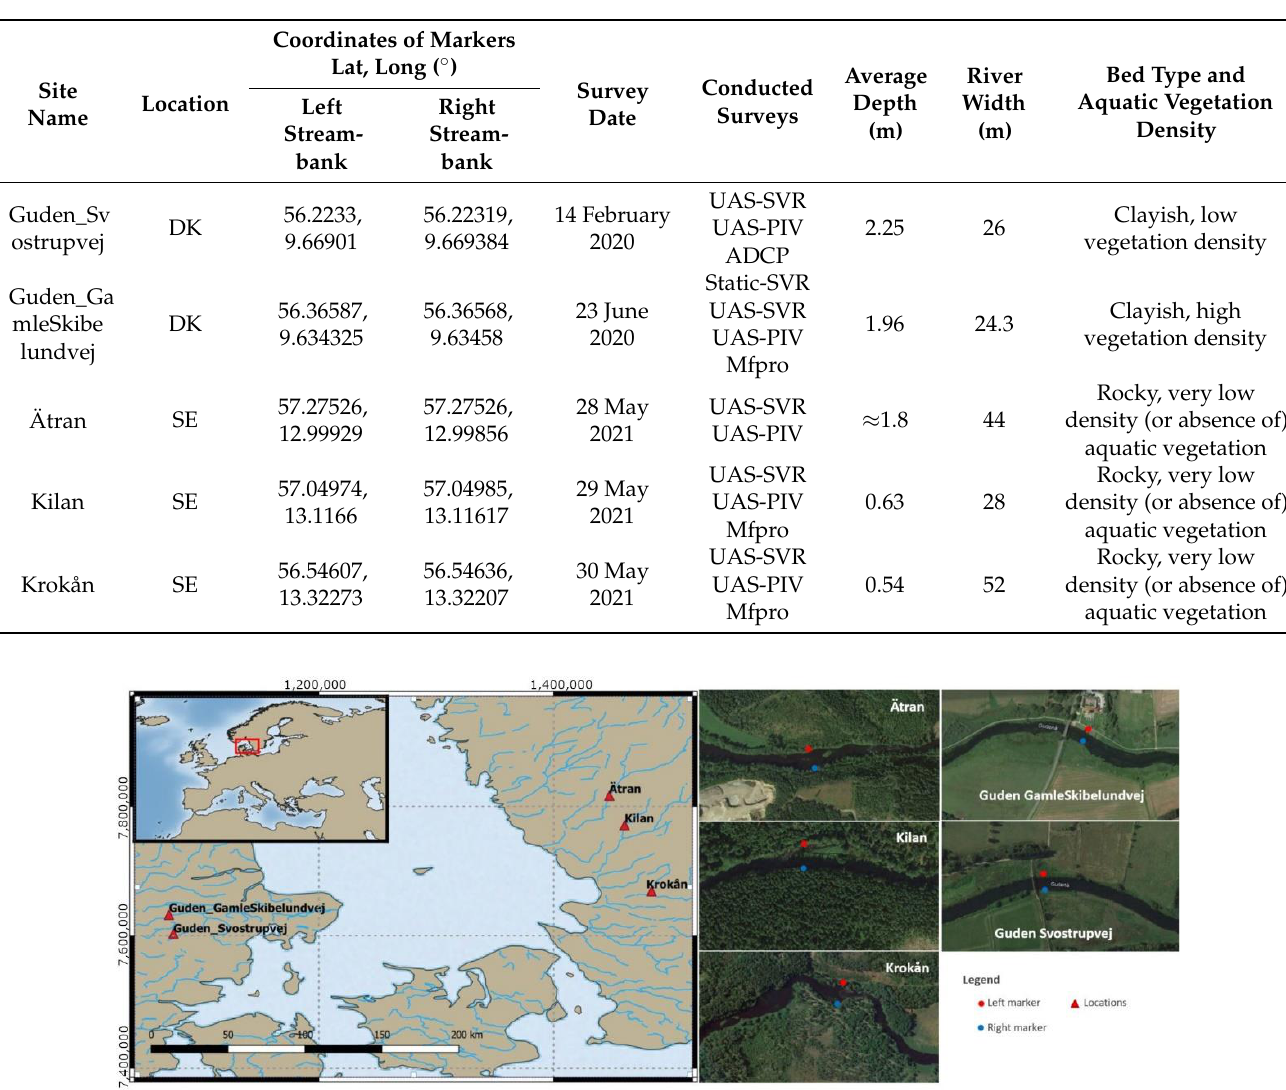
Table 1. Overview of the surveyed sites. Two XSs were surveyed in one river (Guden Å) in Denmark (DK), whilst three different rivers (Ätran, Kilan, Krokån) were surveyed in Sweden (SE). Different surveys were conducted with different instruments: UAS-borne OTT SVR100 (“UAS-SVR”), UAS- borne Particle Image Velocimetry (“UAS-PIV”), Static OTT SVR100 from bridge (“Static-SVR”) and, as ground-truth, either the electromagnetic probe OTT MFpro (“MFpro”) or the ADCP Teledyne StreamPro (“ADCP”). The river average depth, width, bed type and aquatic vegetation density are reported.